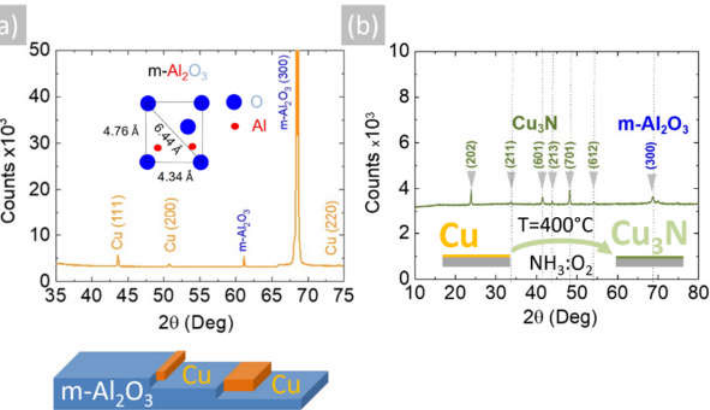
Figure 2. ( a ) XRD of Cu on m-Al 2 O 3 obtained at 600 °C showing peaks belonging to Cu and m-Al 2 O 3 ; inset shows the oxygen-terminated surface of m-Al 2 O 3 ; ( b ) XRD of Cu 3 N obtained from Cu under NH 3 : O 2 at 400 °C showing the peaks belonging to the anti-ReO 3 cubic crystal structure of Cu 3 N and m-Al 2 O 3 .